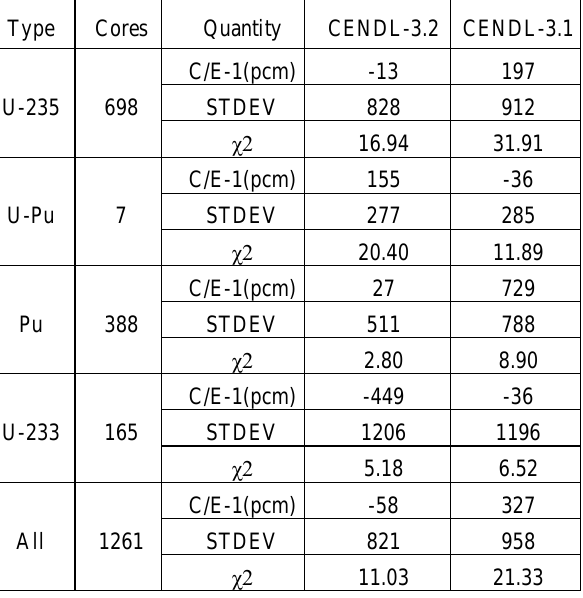
Table 3. The comparison of the benchmark testing for CENDL-3.2 and